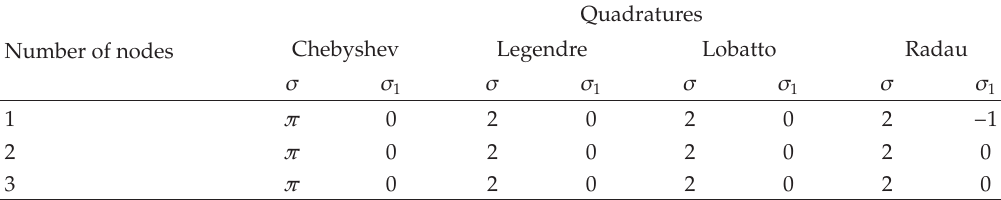
Table 1: Values of the parameters for the di ff erent quadratures used.